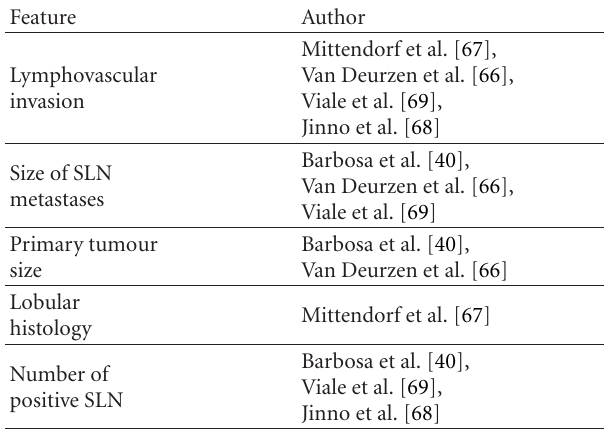
Table 4: Major prognostic factors for non-SLN metastases in patients with minimal SLN